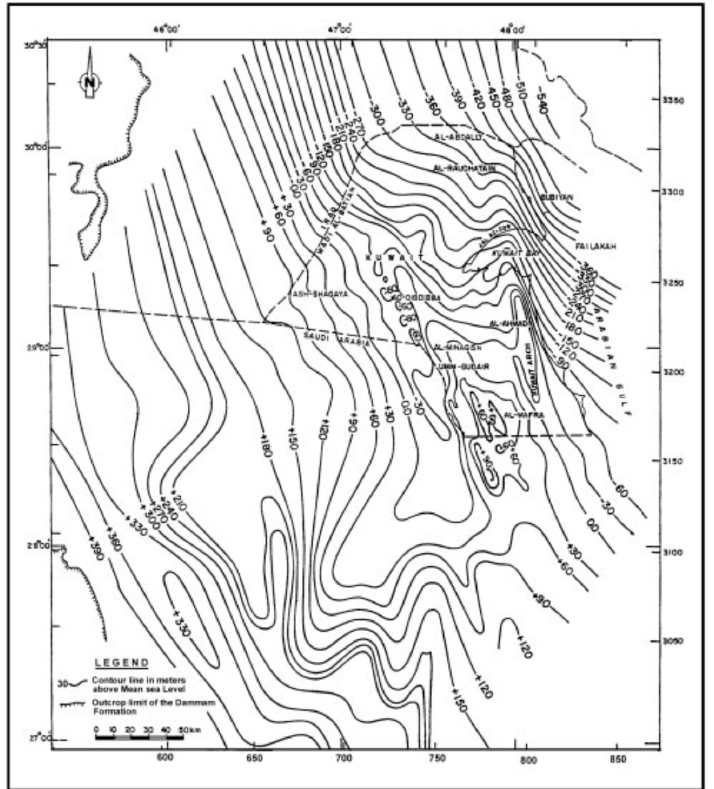
Figure 8. Directional variograms of the log(T) of the Dm aquifer.